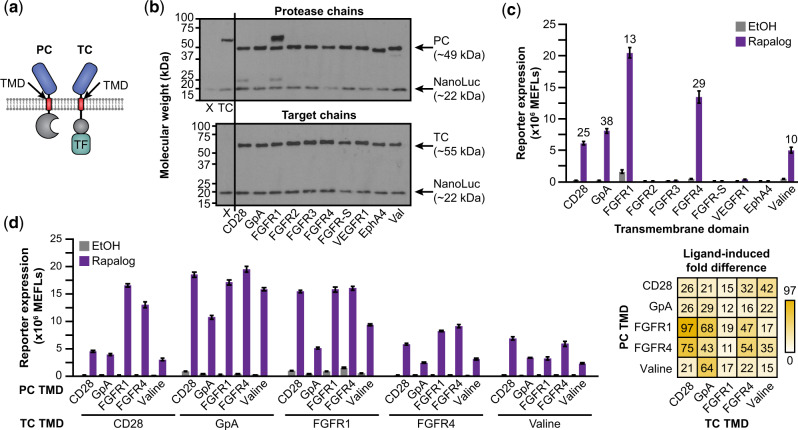
TMD contributions to MESA receptor signaling. (a) This schematic identifies the design choice examined here—the TMD sequence. (b) Effect of TMD choice on the expression of expected bands (PC, TC, cotransfected NanoLuc loading control) versus cleavage products (CD28 and FGFR1 cases). For this experiment, chain expression levels were first normalized to that of CD28-TMD TC expression (M, upper panel) by varying transfected plasmid dose through iterative western blot analyses (Supplementary Figure S6). The X denotes a vector-only negative control (including NanoLuc); TC denotes a CD28-TMD TC. (c) Paired TMD substitution conferred varying effects on receptor performance. Labels indicate the TMD that was used on both the TC and PC. Numbers above bars indicate fold difference when the ligand induced a significant signal above background (two-way ANOVA, P < 0.05). (d) Combinatorial TMD substitution further improved receptor performance. Fold difference is reported in the heatmap at right. All combinations exhibit a significant increase in reporter expression upon ligand treatment (three-way ANOVA, P < 0.001). Bars depict the mean of three biological replicates, and error bars represent the S.E.M. Outcomes from ANOVAs and Tukey’s HSD tests for (c, d) are in Supplementary Notes S1, S2, and S3.